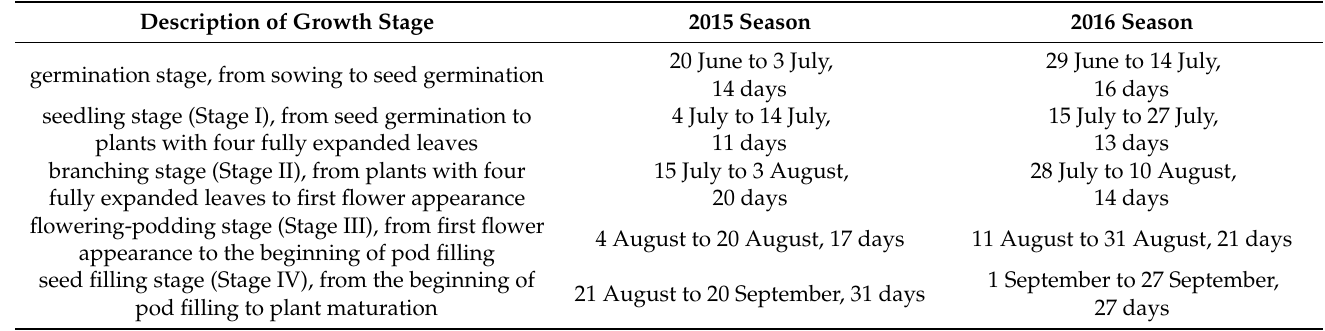
Table 2. Divisions of the whole soybean growth periods in 2015 and 2016